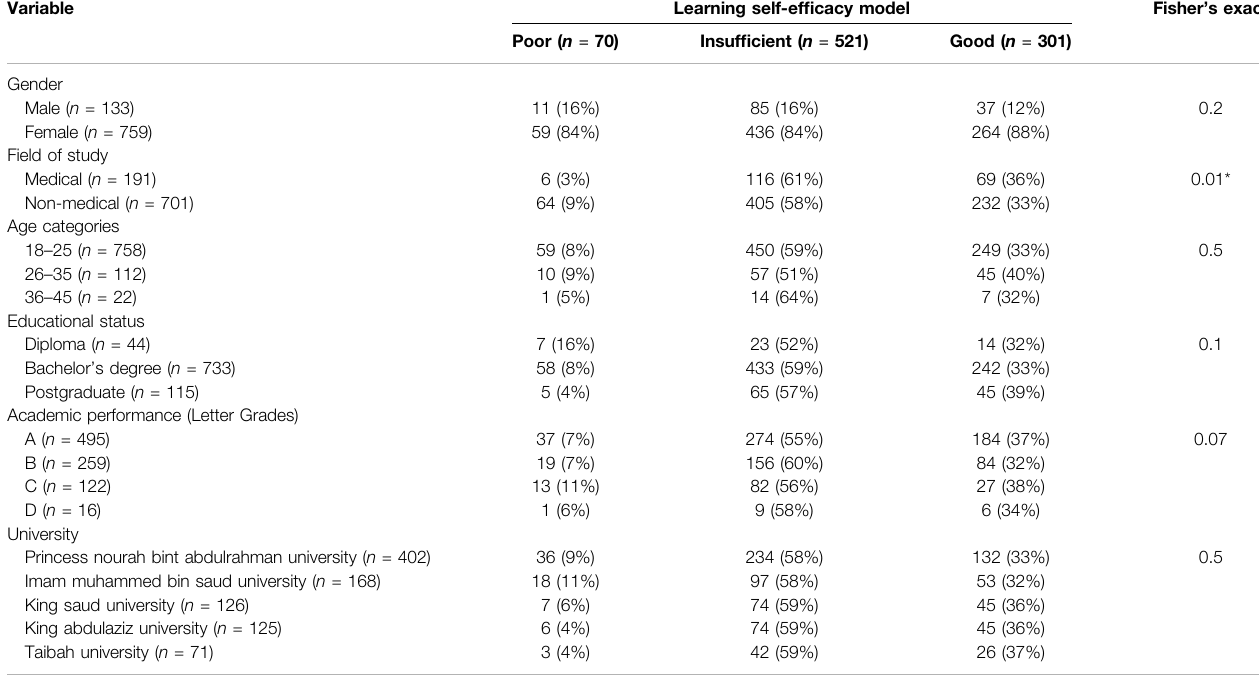
TABLE 2 | Level of self-ef fi cacy in the learning domain by student characteristics.